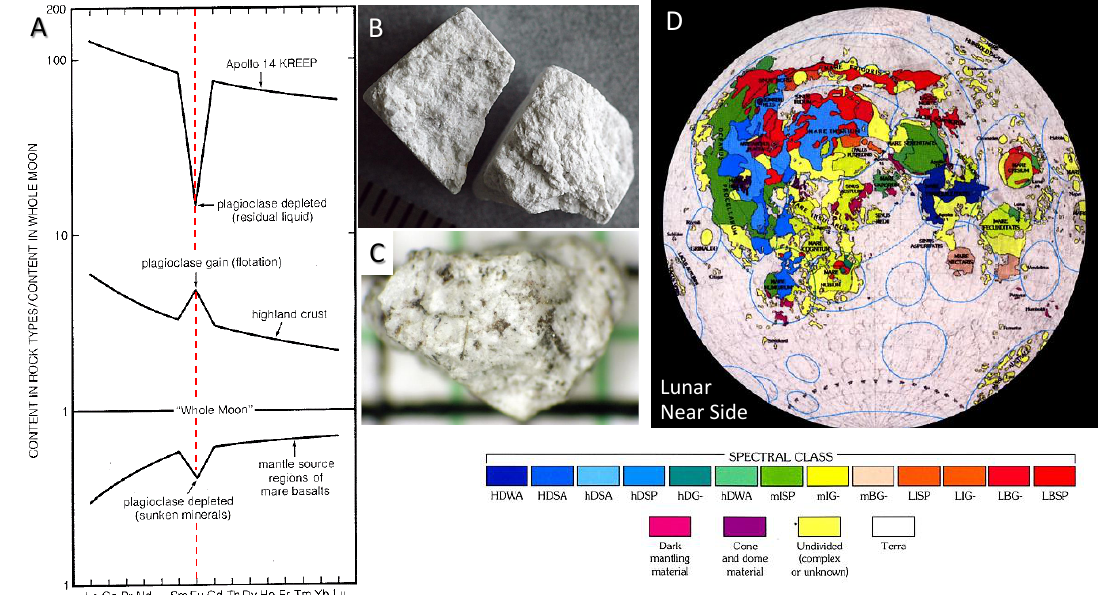
Figure 1. Sampling of important science results till Apollo era. ( A ) Eu anomaly in returned samples. Complementary signature of Eu between highland and mare rocks provided strong support for lunar magma ocean (Source: Modified from [39,40]) . ( B ) Anorthosite cataclasite sample, 60025. The purity of plagioclase suggested a plagioclase-rich floatation crust as an outcome of global magma ocean differentiation (Source: [41]) . ( C ) Lunar granite sample, 12032, 366-19 represent a restricted suite of evolved rocks produced towards late stages of the magma ocean (Source: [42]) . ( D ) Spectral variability of basalts on the lunar near side, based on telescopic observations, provide a sampling of the mantle (Source: Modified from [33,43,44])